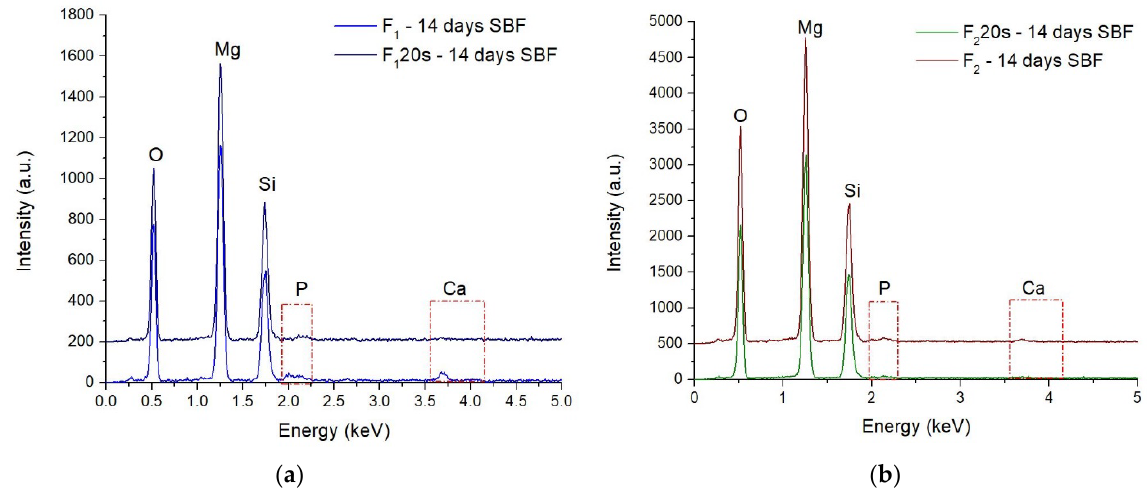
Figure 12. EDS spectra for F 1 , F 1 20s samples ( a ) and F 2 , F 2 20s samples ( b ) after 14 days in SBF. Table 2. Chemical composition of samples after 14 days in SBF.